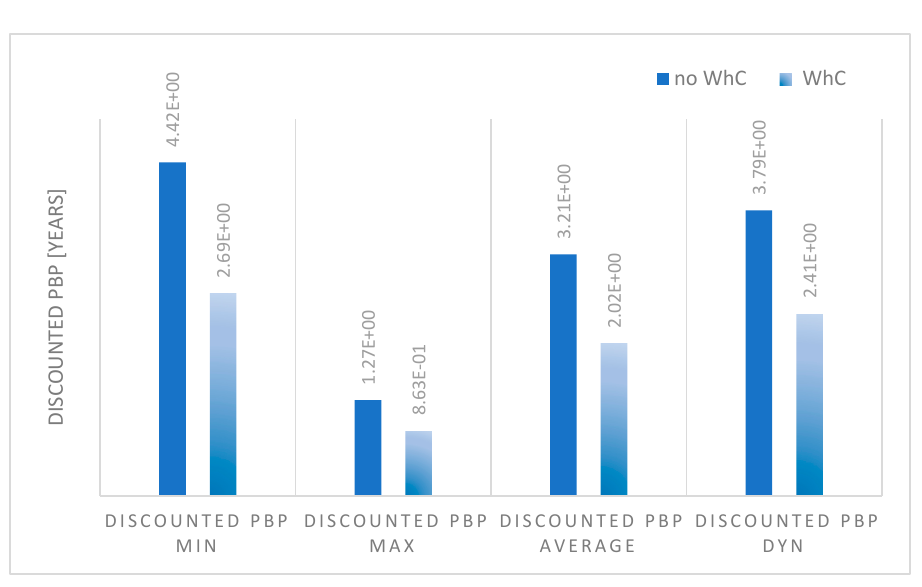
Figure 8. Discounted Payback Period (dPBP) calculated by varying the energy cost, where “no WhC” = no participation in the White Certificates mechanism, and “WhC” = participation in the White Certificates